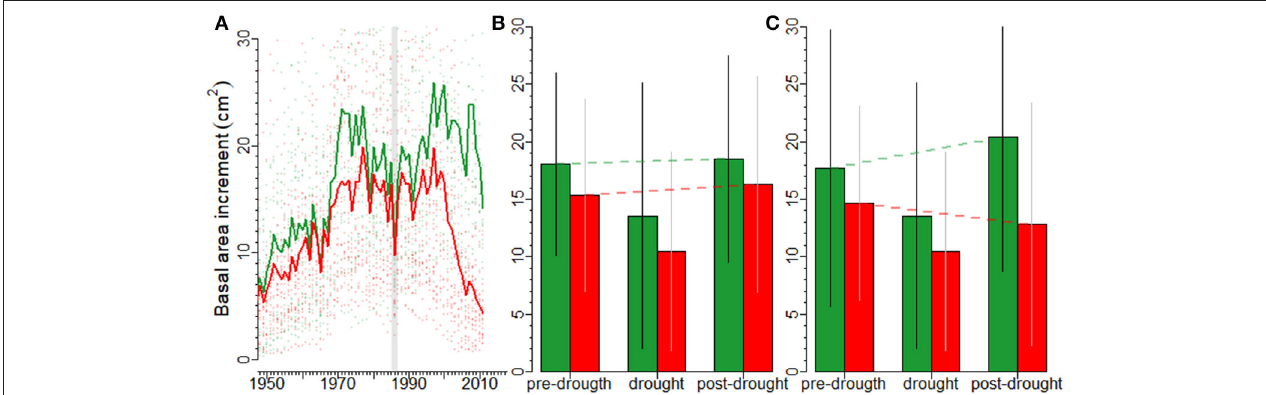
FIGURE 2 | Impacts of drought on forest growth assessed at different time scales in silver fir. Responses of declining (red lines, symbols and bars) and non-declining (green lines, symbols and bars) silver firs to the severe 1986 drought (vertical line); (A) the mean basal area increments (BAI) of declining and non-declining individuals since 1950 and the divergence between the two vigor classes from the 1990s onwards, (B) the short-term pre- (three years before), drought (1986), and post-drought (three years after) BAI values of declining and non-declining individuals are shown. The red and green dashed lines indicate the BAI linear trends from pre- to post-drought growth (resilience; capacity to recover pre-growth levels after drought) in declining and non-declining trees, respectively. Finally, in (C) the long-term pre- (25 years before), drought (1986), and post-drought (25 years after the drought) BAI trends of declining and non-declining individuals are presented. The dashed lines indicate the linear trends from pre- to post-drought BAI (resilience; capacity to recover pre-growth levels after drought. In the figures (B,C) bars show means and standard